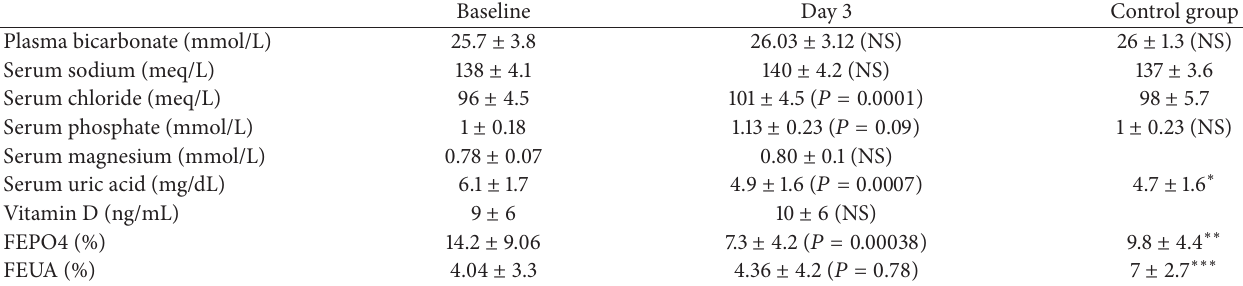
Table 1: Changes in biological parameters between baseline and day 3 after